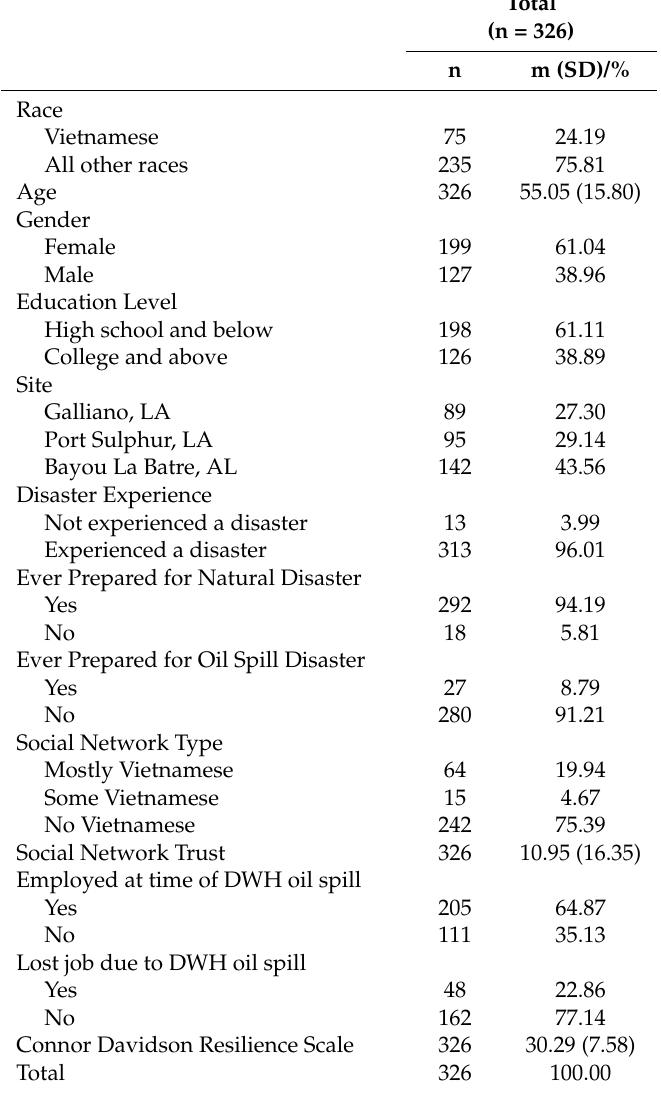
Table 1. Characteristics of study sample (N =